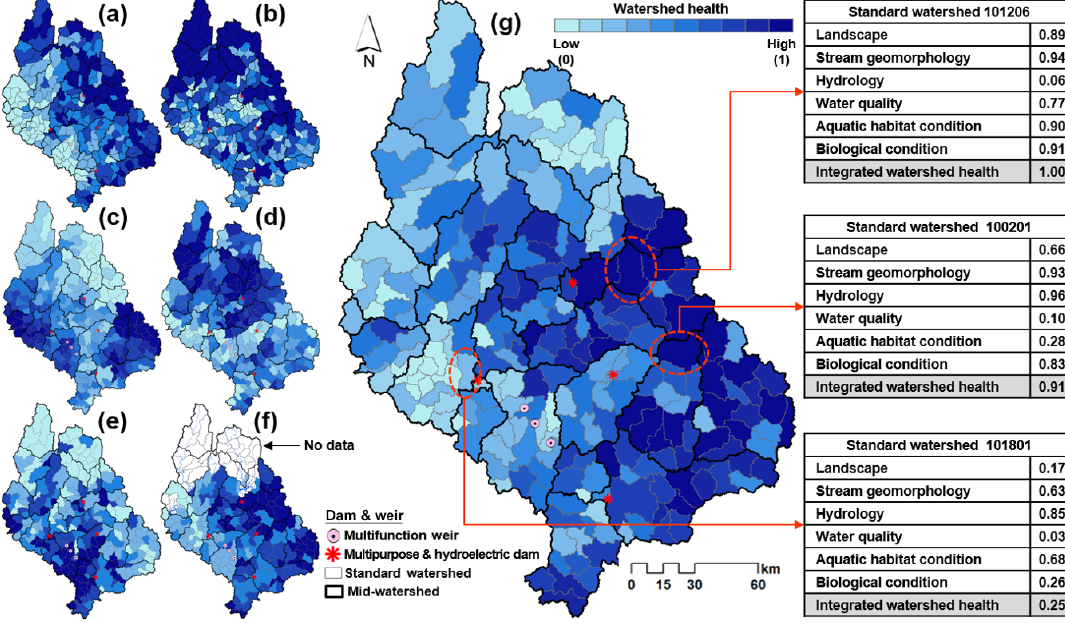
Figure 12. Watershed-health index results for the (a) landscape, (b) stream geomorphology, (c) hydrology, (d) water quality, (e) aquatic habitat, (f) biological condition, and (g) integrated watershed